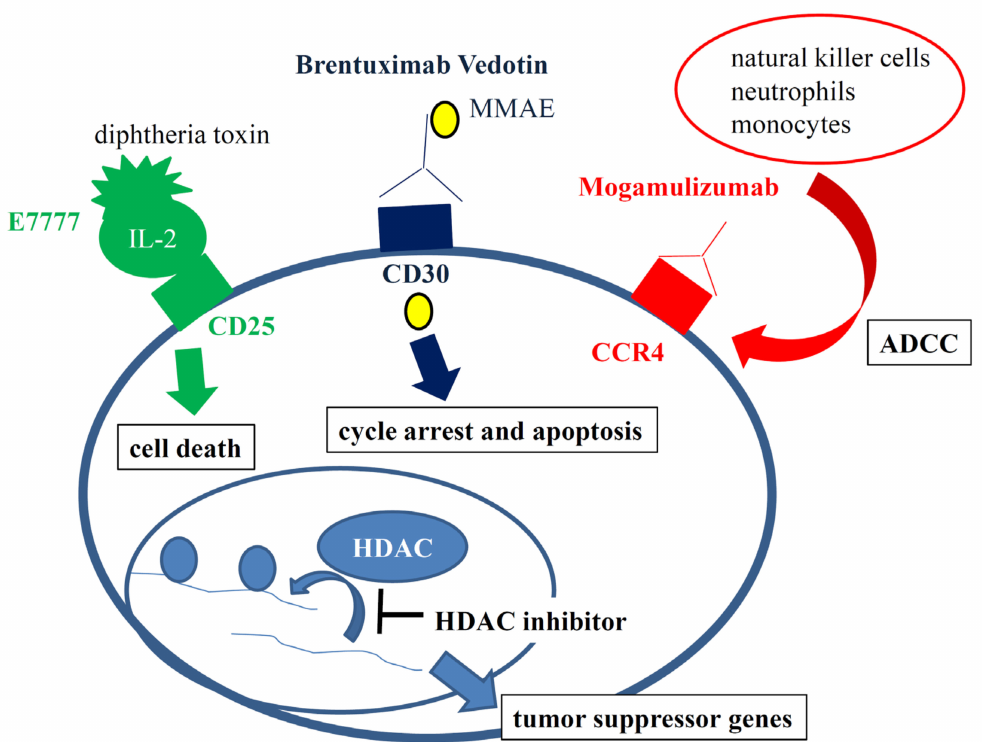
Figure 1. Current molecular targets for MS/SS are CD30, CCR4, CD25, CD52, and HDACs. Brentuximab Vedotin is an antibody–drug conjugate made of a chimeric monoclonal anti-CD30 antibody and monomethyl auristatin E (MMAE), a cytotoxic antitubulin agent. Mogamulizumab is a humanized monoclonal antibody against CCR4, whose antitumor activity is mediated by antibody-dependent cellular cytotoxicity (ADCC). E7777 is a sophisticated version of denileukin diftitox, which is a fusion protein composed of human IL-2 and the cytotoxic and membrane-translocating domains of the diphtheria toxin. Histone deacetylase (HDAC) inhibitors increase acetylation of histones and other proteins, leading to the remodeling of chromatins and an increase in the expression of tumor suppressor